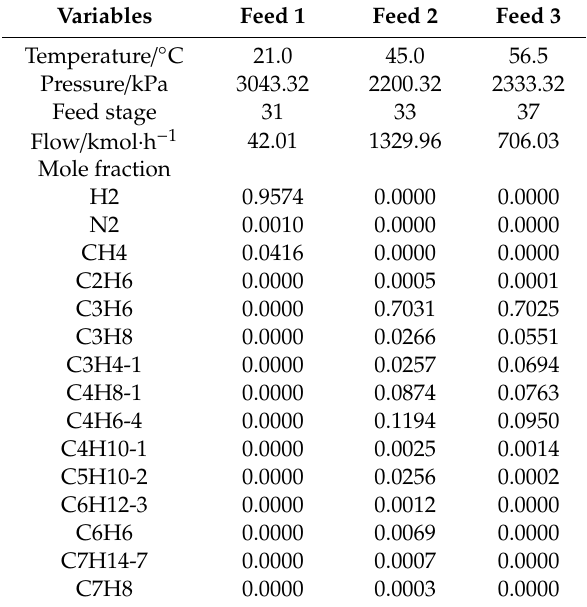
Table 4. The parameters of feed stream for the depropanization column.